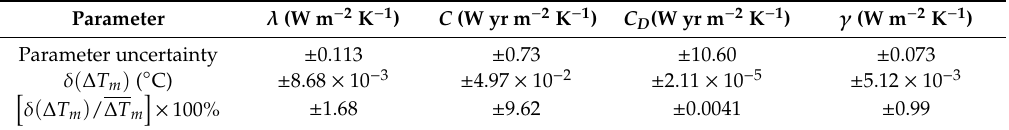
Table 2. Absolute δ ( ∆ T m ) ( ◦ C) and relative by ± 10% uncertainty in model